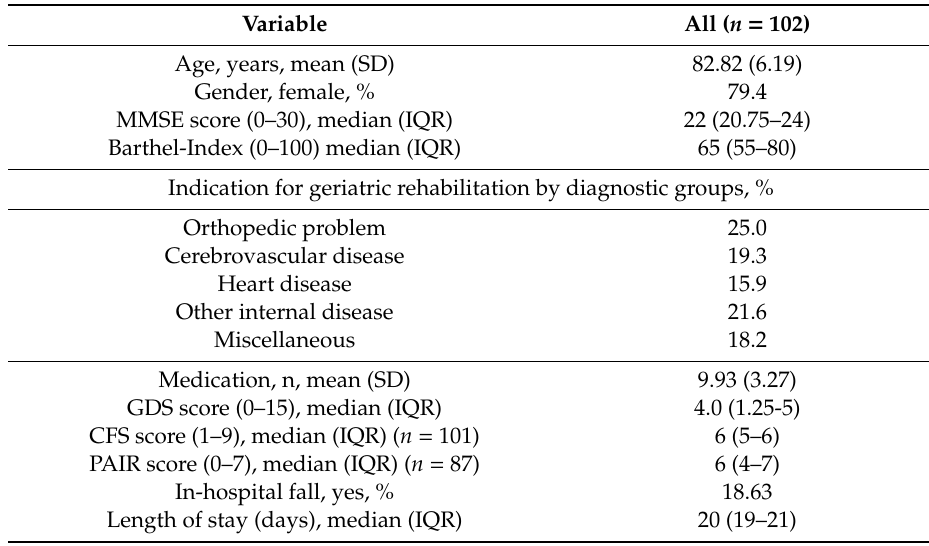
Table 1. Participants’ baseline characteristics of the total study sample ( n =